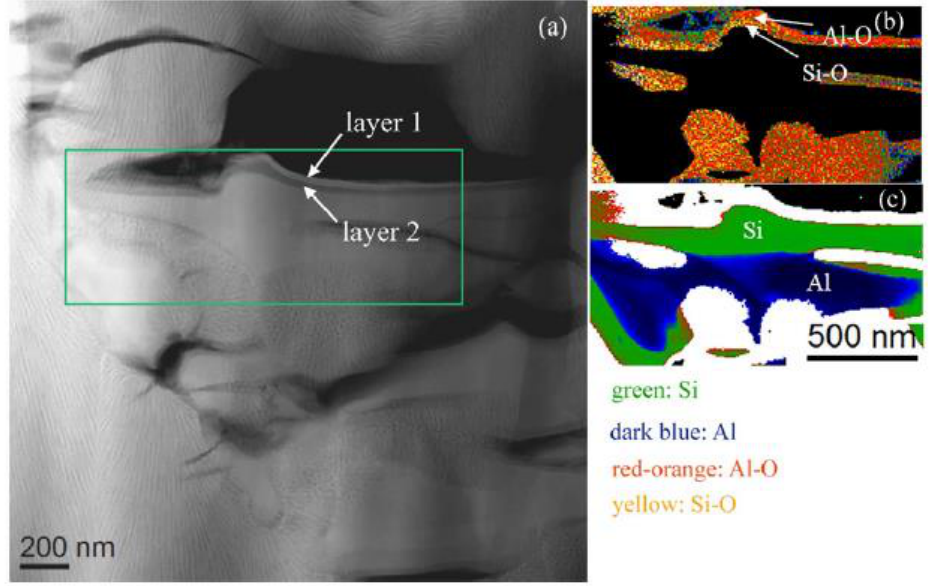
Figure 18. High magnification STEM micrographs of Si flakes inside oxide layer: ( a ) STEM micrograph; ( b ) bulk plasmon energy map of the selected area highlighting the oxide regions; ( c ) bulk plasmon energy map of the selected area highlighting the elemental Si and Al domains. Reprinted with permission of [99].